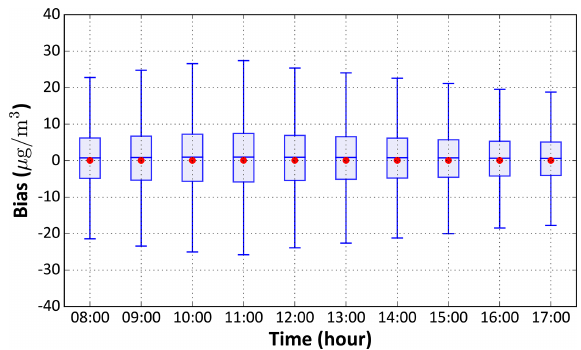
Figure 8. Boxplots of the temporal dependence of the bias in hourly PM 2 . 5 estimates (µgm − 3 ) in 2018 in China. In each box, the red dot represents the mean bias, and the middle, lower, and upper horizon- tal blue lines represent the median bias, 25th percentile, and 75th percentile,